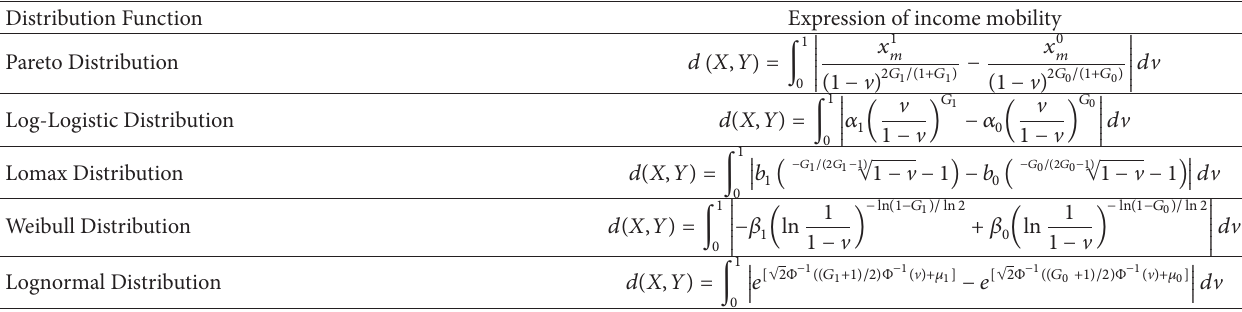
Table 3: Income mobility of the five Distribution Functions.